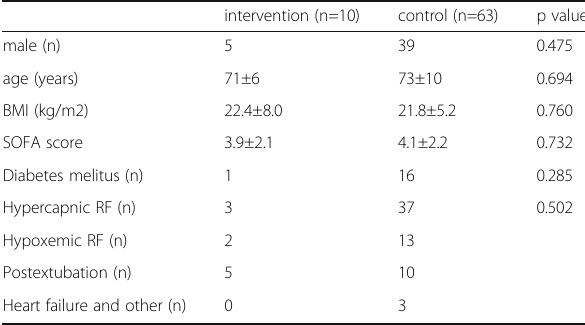
Table 1 (abstract 0060). Demographics of patients and reasons of noninvasive